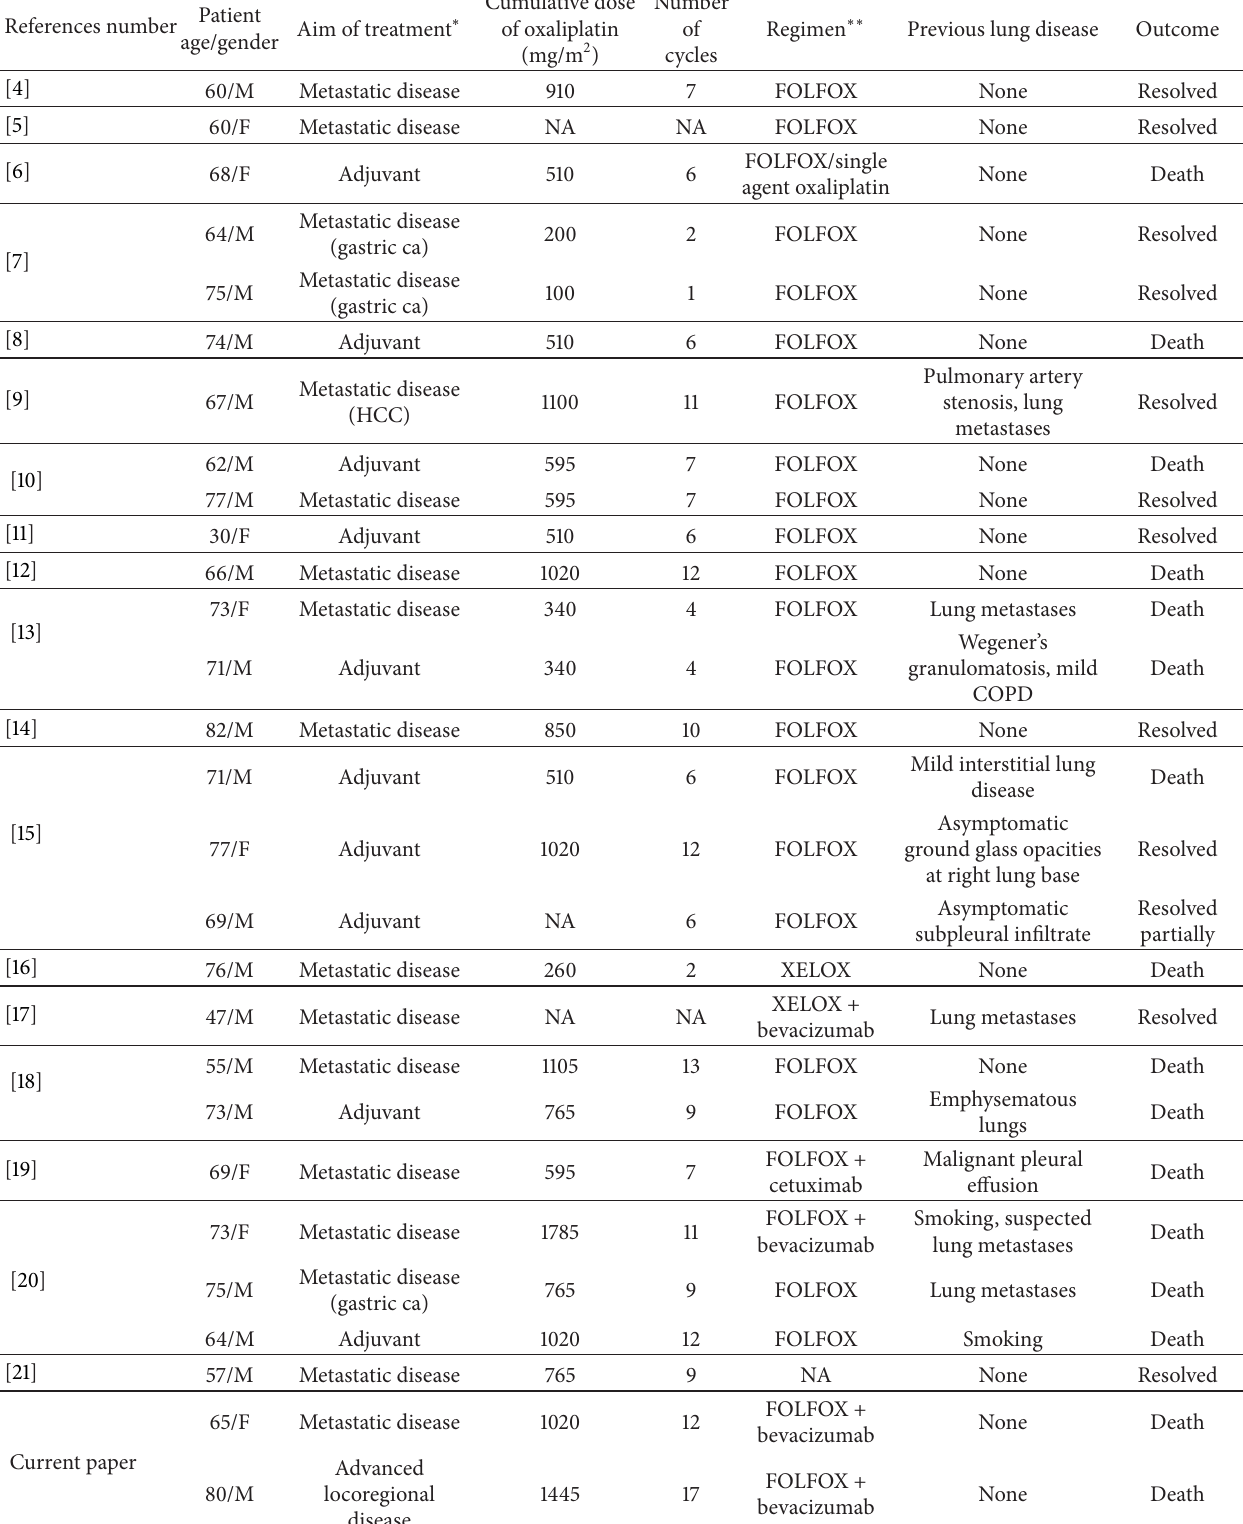
Table 1: Reported cases of pulmonary toxicity related to oxaliplatin ∗ . Cumulative dose Patient References number Aim of treatment ∗ of age/gender